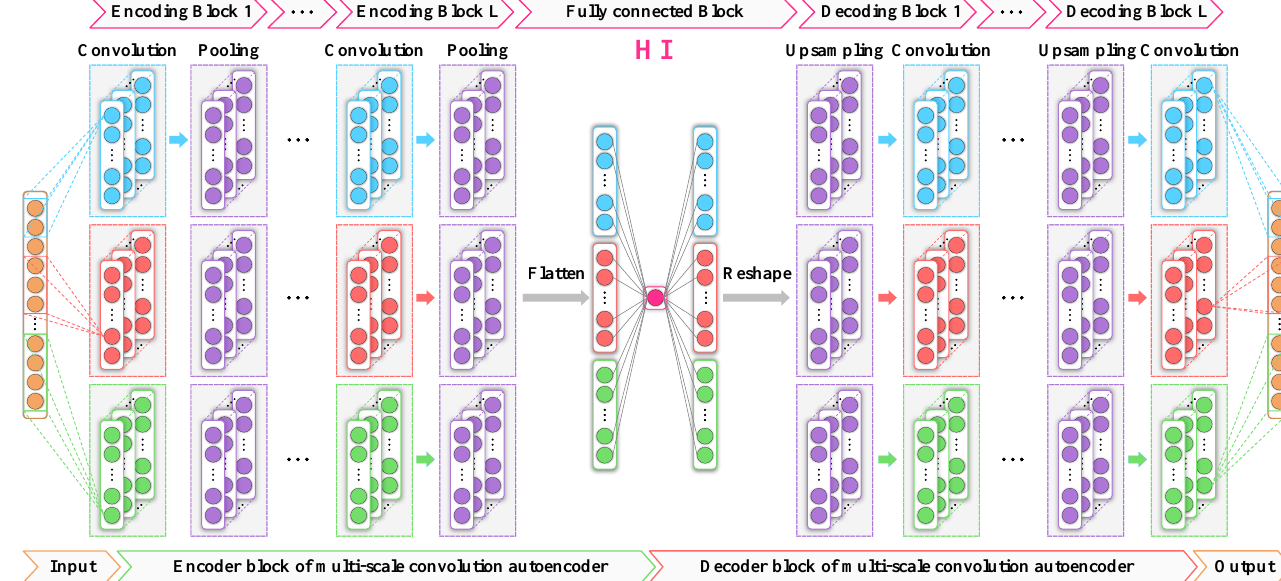
Figure 3. The structure of